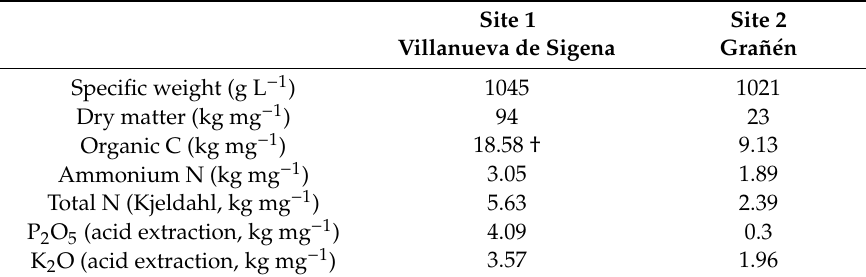
Table 3. Physicochemical characteristics of the PS applied at each